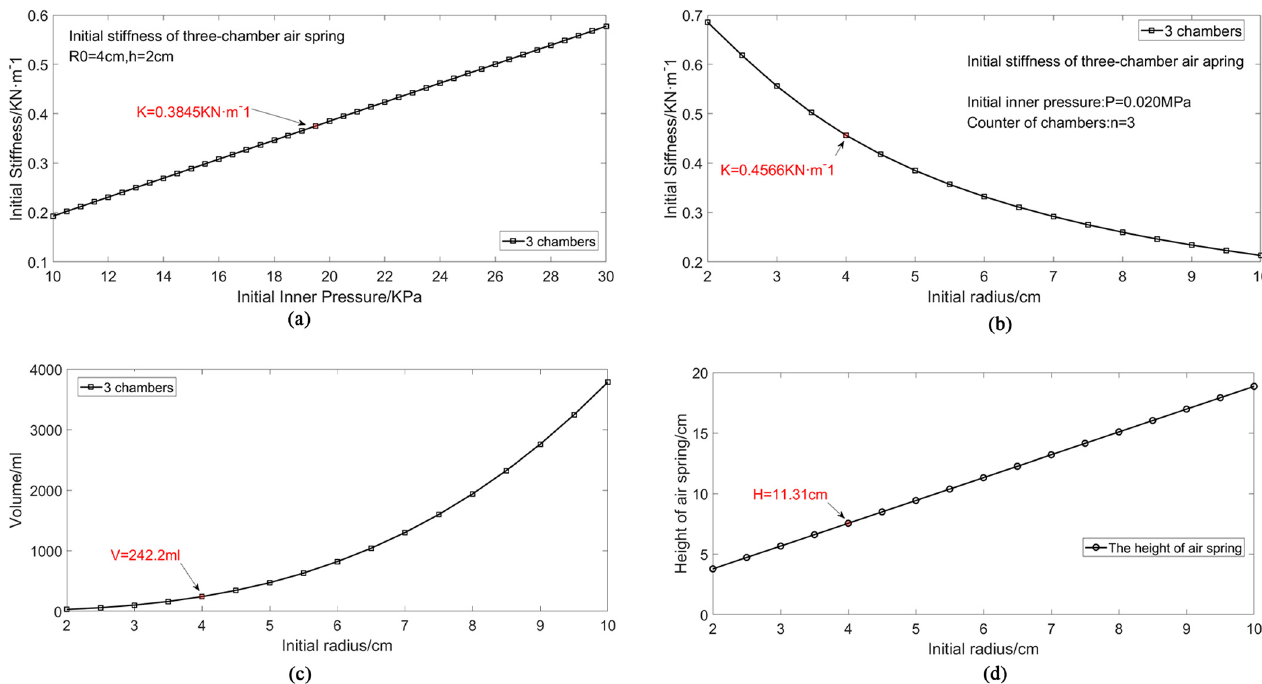
Fig. 11. In fl uence of parameters on stiffness (a) Initial stiffness and initial pressure, (b) Initial stiffness and radius, (c) Initial volume and initial radius, (d) Height and initial radius.